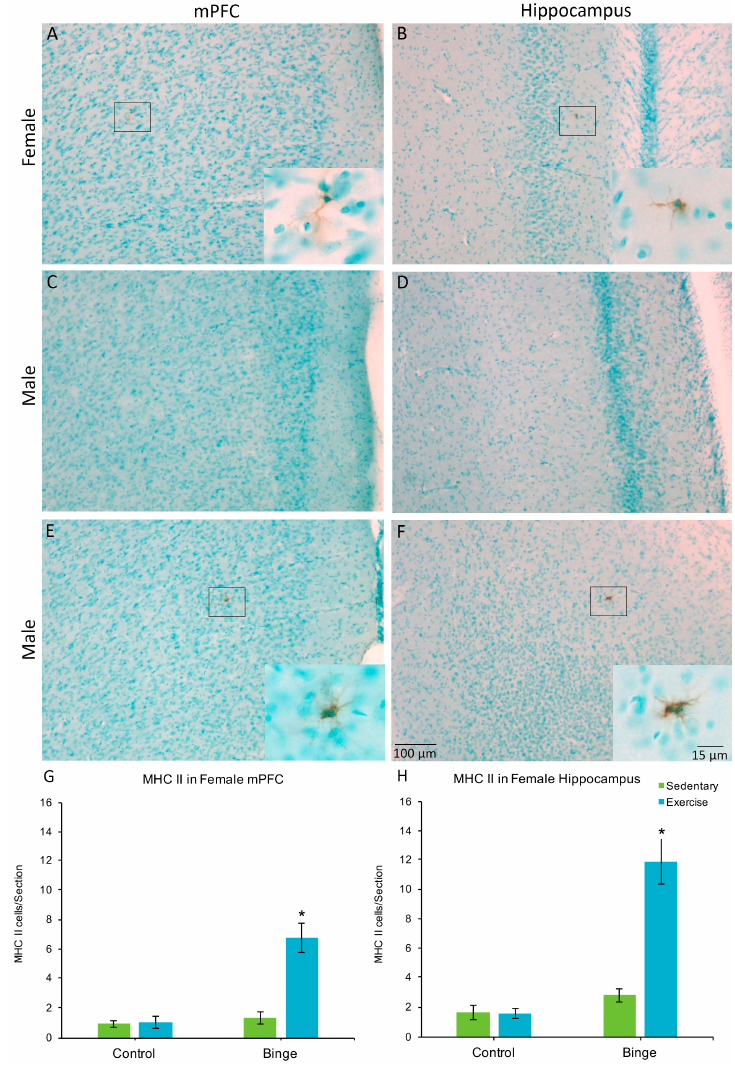
Figure 4. MHC II+ microglia were found in the mPFC ( A ) and hippocampus ( B ) of females but not males ( C , D ), with the exception of one sedentary binged male ( E , F ). In females, the combination of binge alcohol and exercise resulted in more MHC II+ cells in the mPFC ( G ) and hippocampus ( H ) the mPFC or the hippocampus. * p <